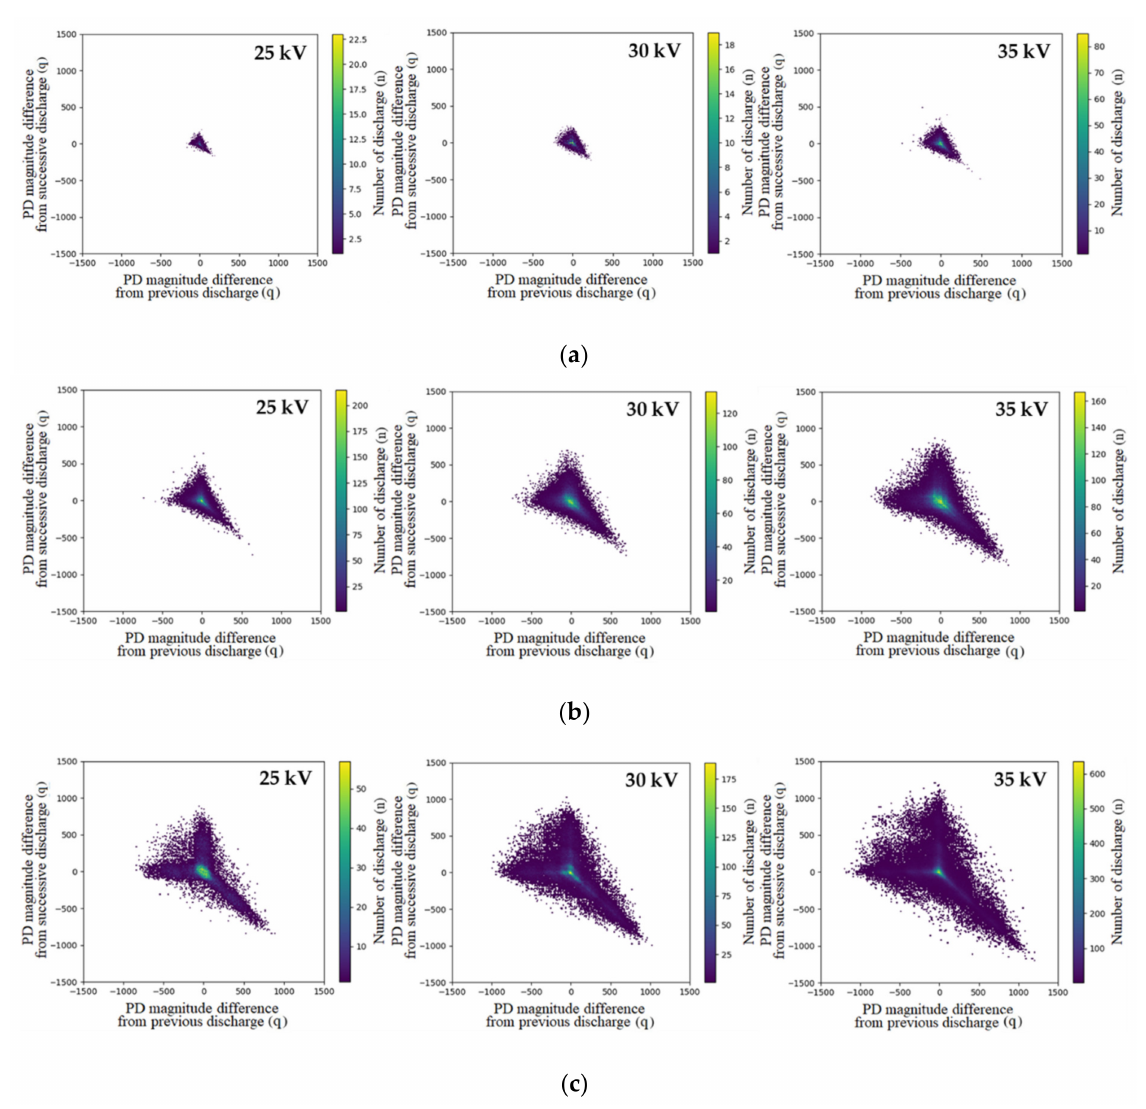
Figure 8. DC void discharge patterns according to the temperature of the specimen and magnitude of the applied voltage: ( a ) 55 ◦ C; ( b ) 65 ◦ C; ( c ) 75 ◦